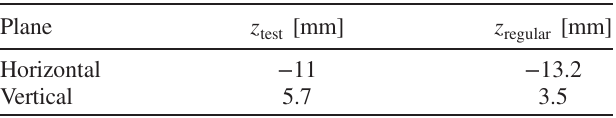
TABLE III. Target positions used during the test ( z regular scraping ( z ). The target positions are different by regular 2.2 mm on each plane.